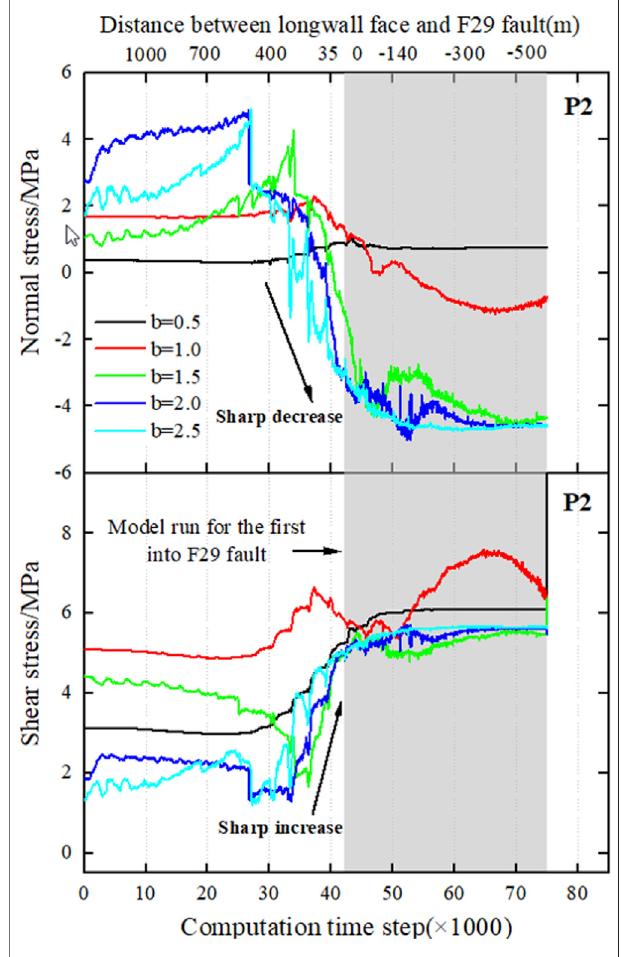
FIGURE 8 | Change laws of normal stress and shear stress with mining working face advance at different ground stress.